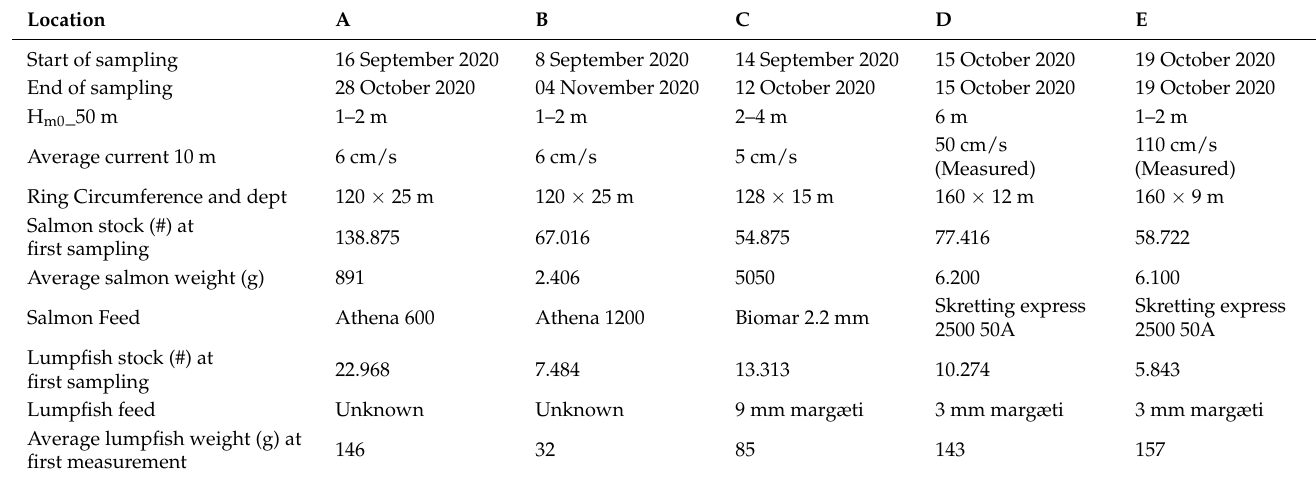
Table 1. Table containing information about the different localities where lumpfish were